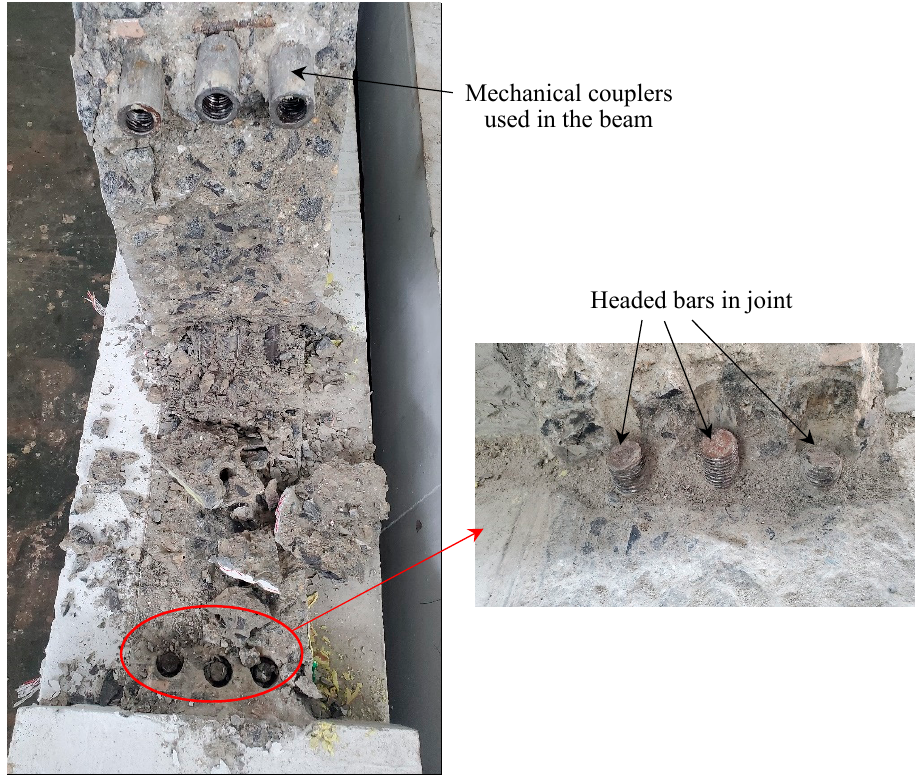
Figure 13. Headed bars and mechanical couplers in LZ-2.